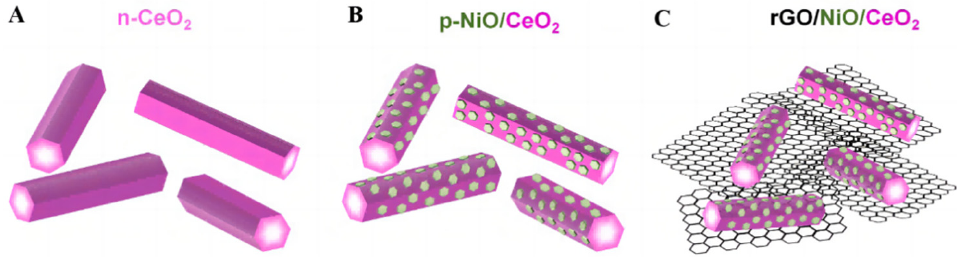
Figure 19. The structural diagrams of ( A ) n-CeO 2 nanorods, ( B ) p-NiO/CeO 2 composite and ( C ) NiO/CeO 2 /rGO hybrid composite